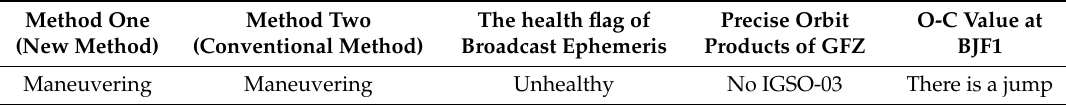
Table 2. Results of IGSO-03 maneuvering detection at 10:00–11:00. Table 3. Results of IGSO-03 maneuvering detection at 19:00–20:00.